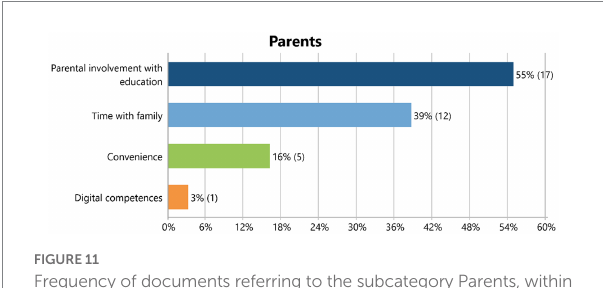
FIGURE 11 Frequency of documents referring to the subcategory Parents, within the category Potential and